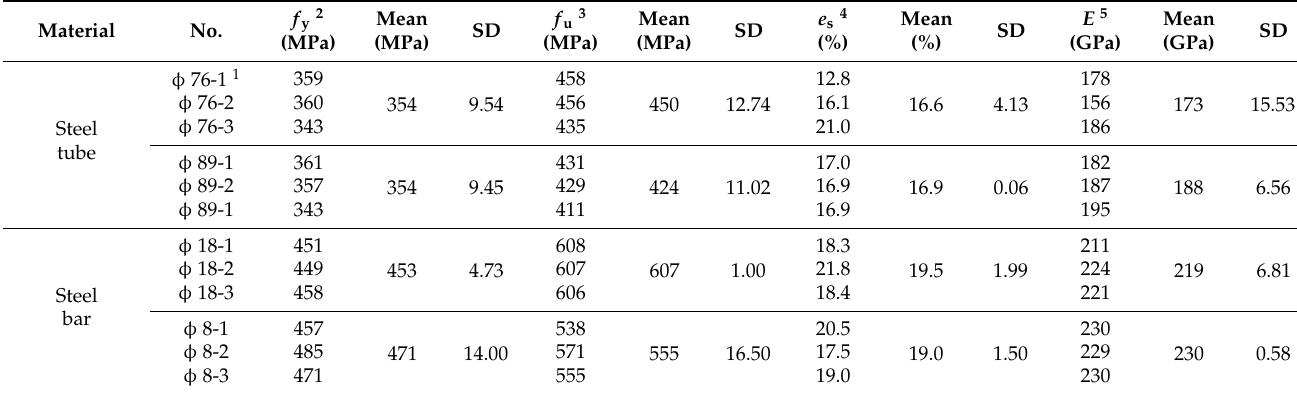
Table 3. Material properties of